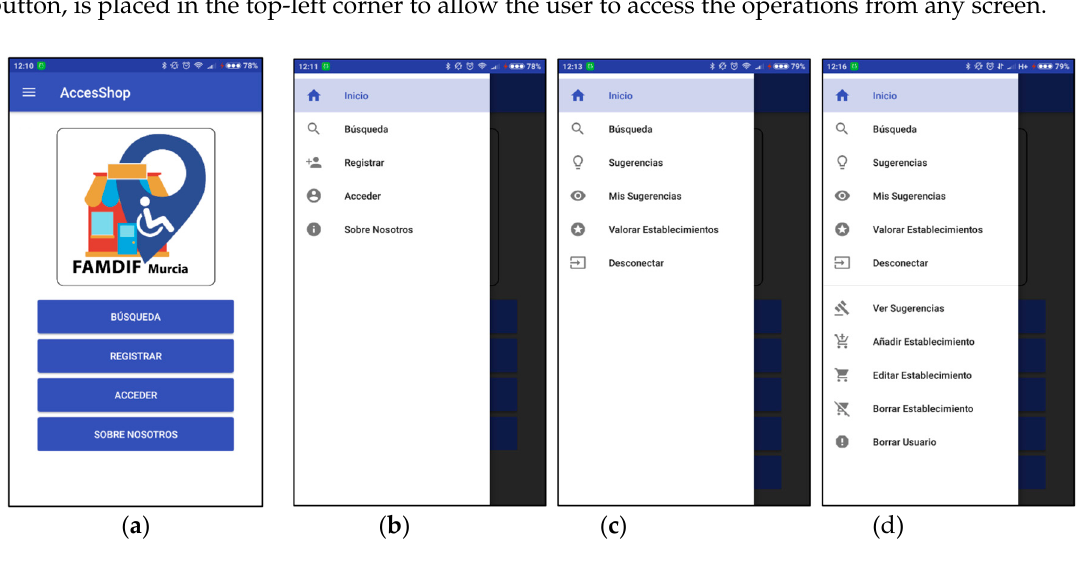
Figure 7. Different views of the app related to the search. ( a ) Search screen. ( b ) Search results after selecting a mark. ( c ) Shop details for an unregistered user. ( d ) Shop details for a registered user.